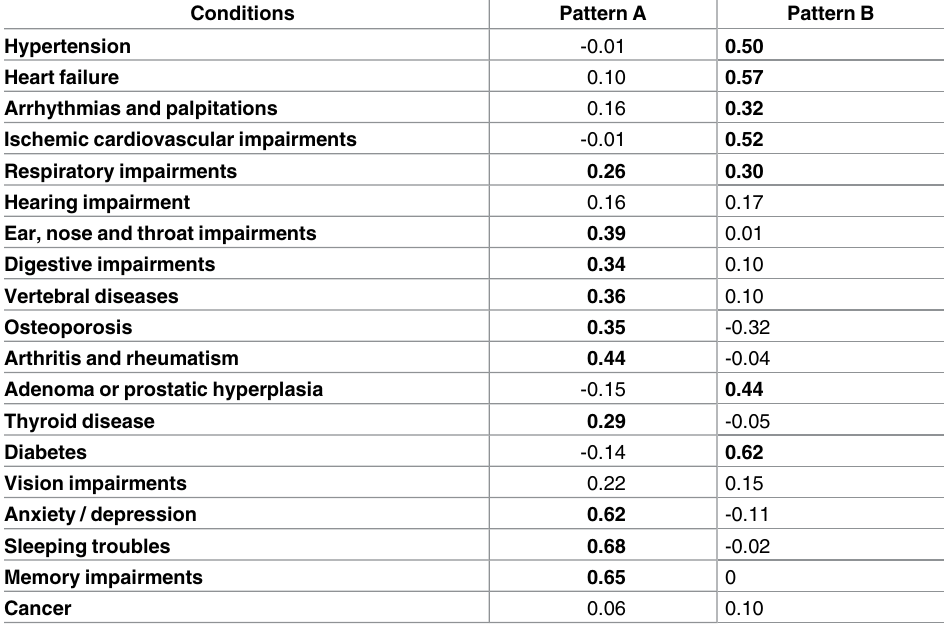
Pattern scores > 0.25 are